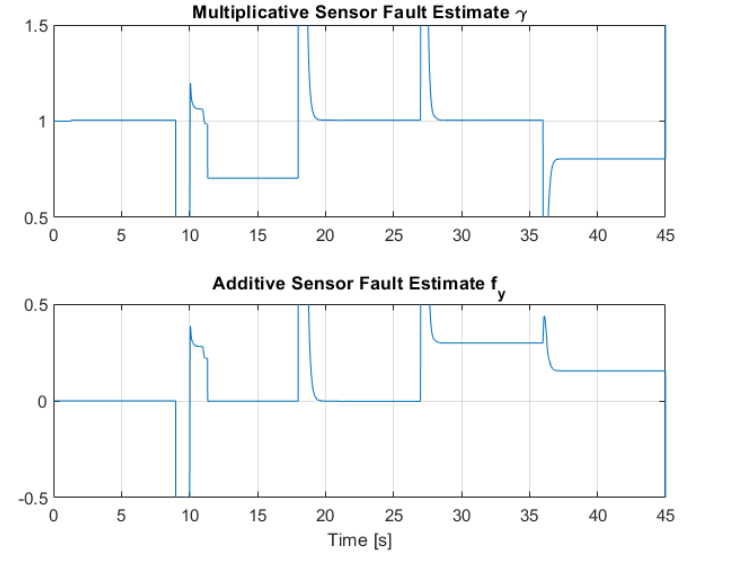
Figure 21. Multiplicative and additive sensor fault estimation by means of RLS for Link